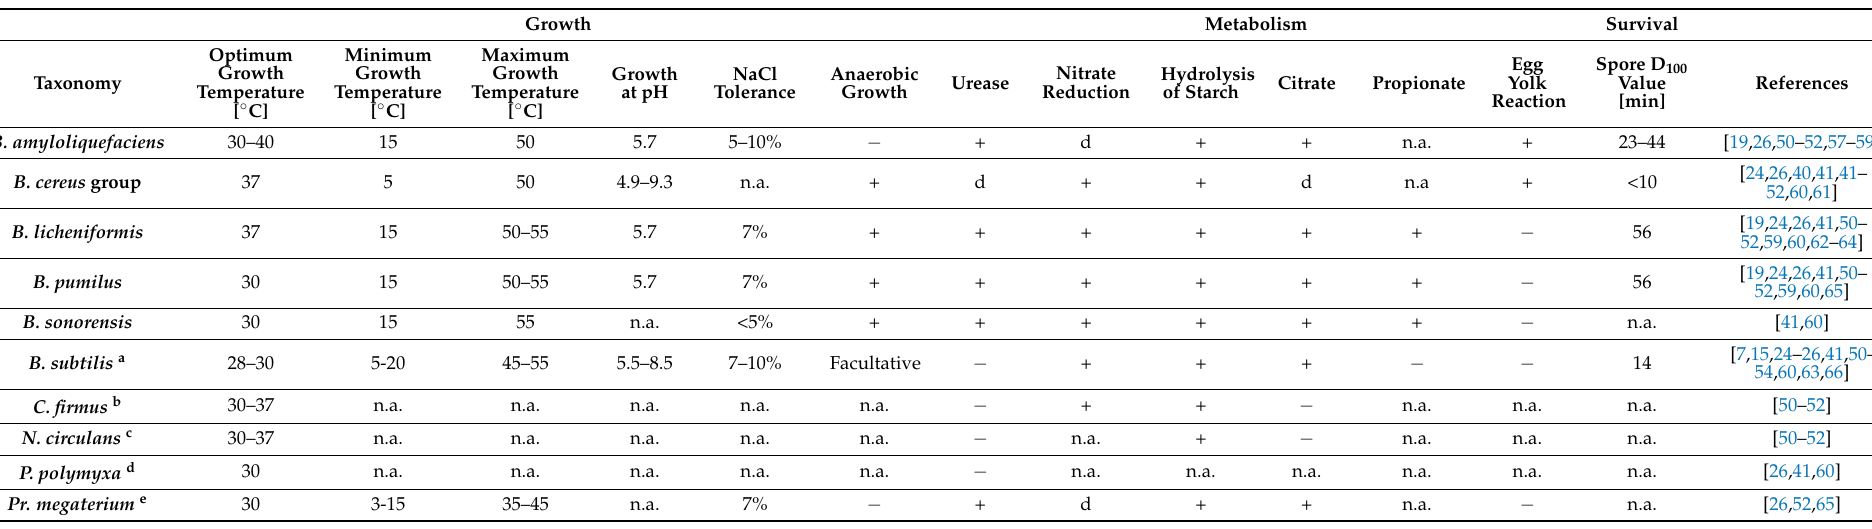
Table 1. Bacterial species that were suggested to cause rope spoilage in bread. The table summarizes data on growth characteristics, metabolism, and spore